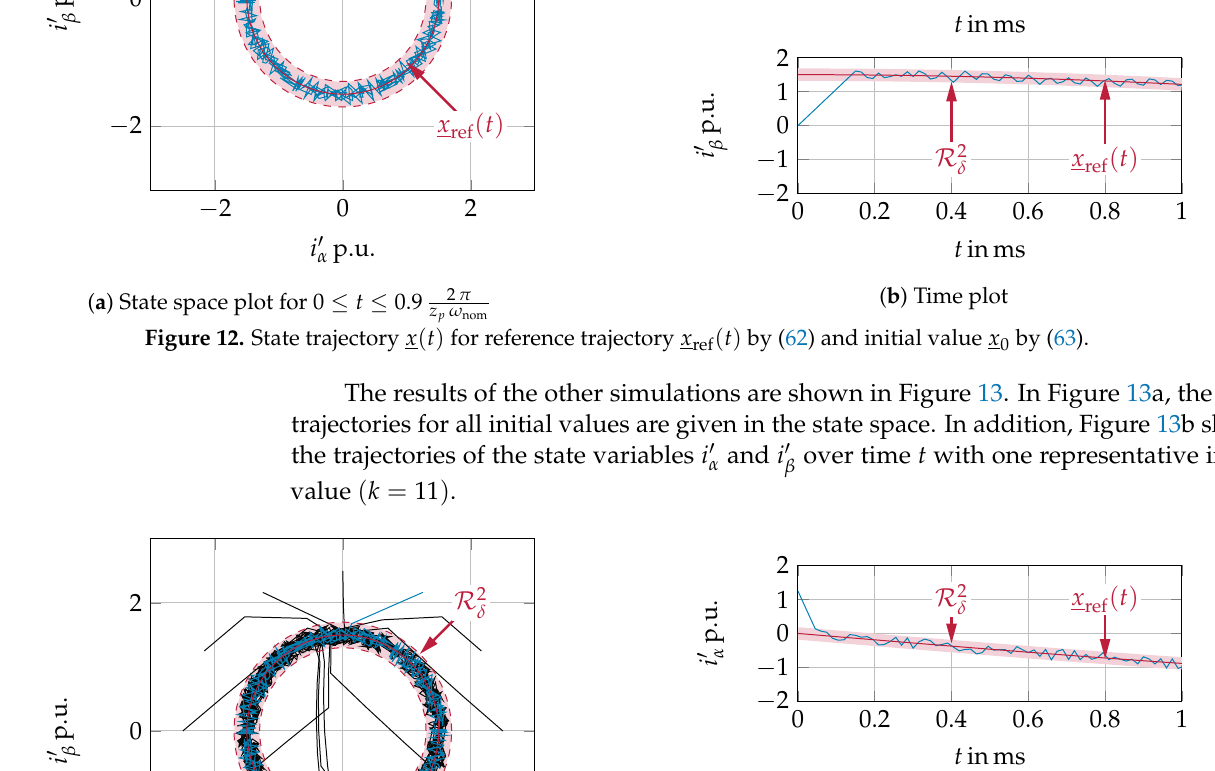
and i (cid:48) over time t with one representative initial α β